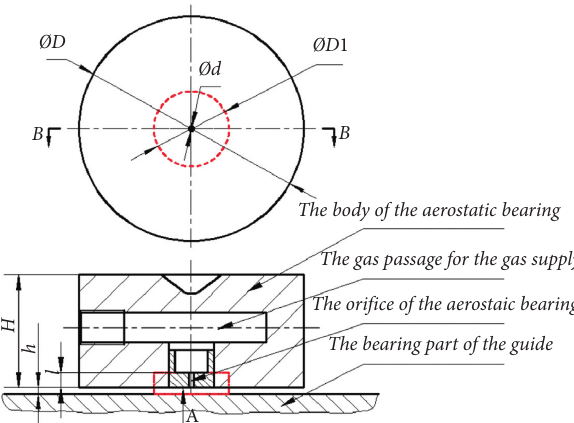
`Figure 1: Sketch map of the physical model of the aerostatic